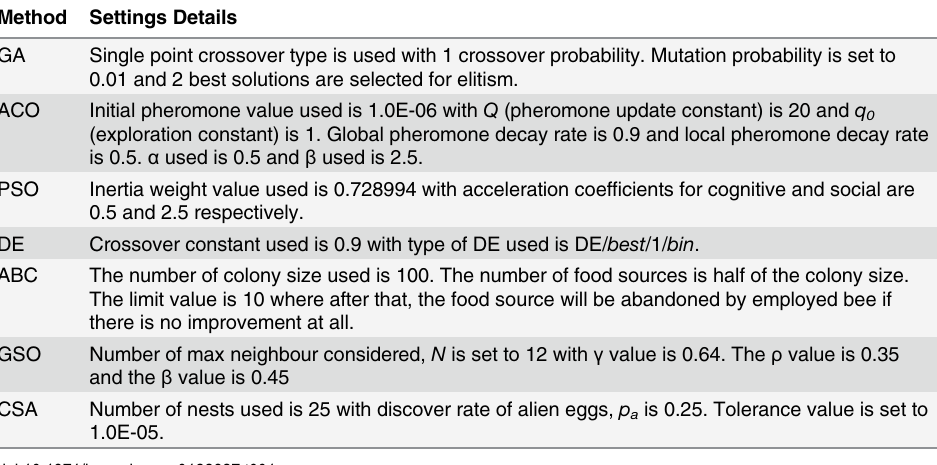
Table 1. Experimental settings of the utilized methods. Method Settings